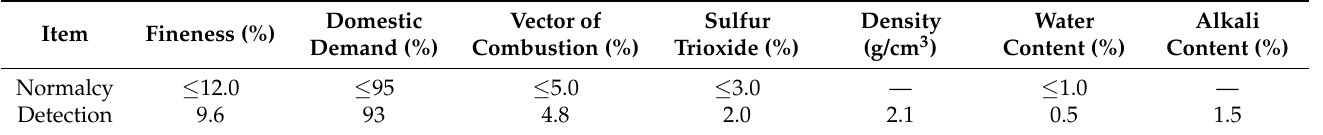
Table 2. Physical indexes of fly